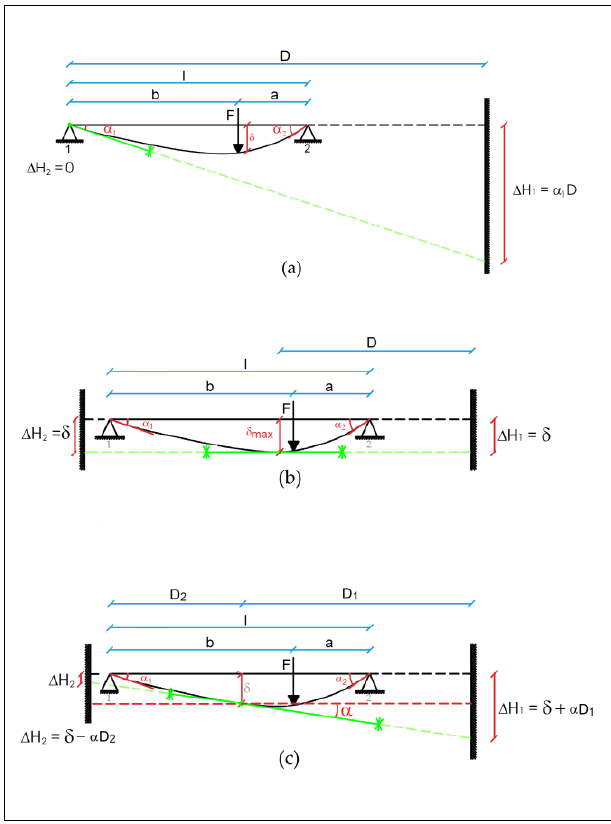
Figure 1. The displacement of the laser footprints: (a) with the pointer subject just to inclination (fixed to the end of the span); (b) with the pointers positioned in the maximum displacement point (with lowering only); (c) with the laser pointers fixed on a point subject to both inclination and lowering.